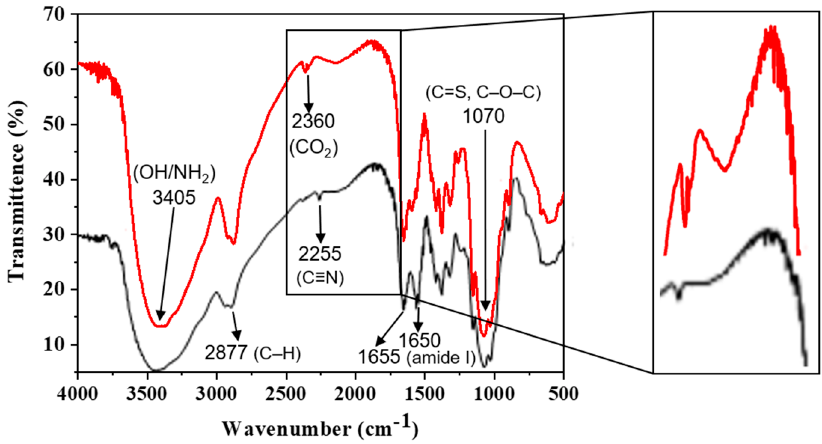
Figure 1. Infrared spectra of CH-based bio-composites, that is, pristine CH bio-composite (red line) and chemically modified CH-AN bio-composite (black line), along with zoomed area showing modification.